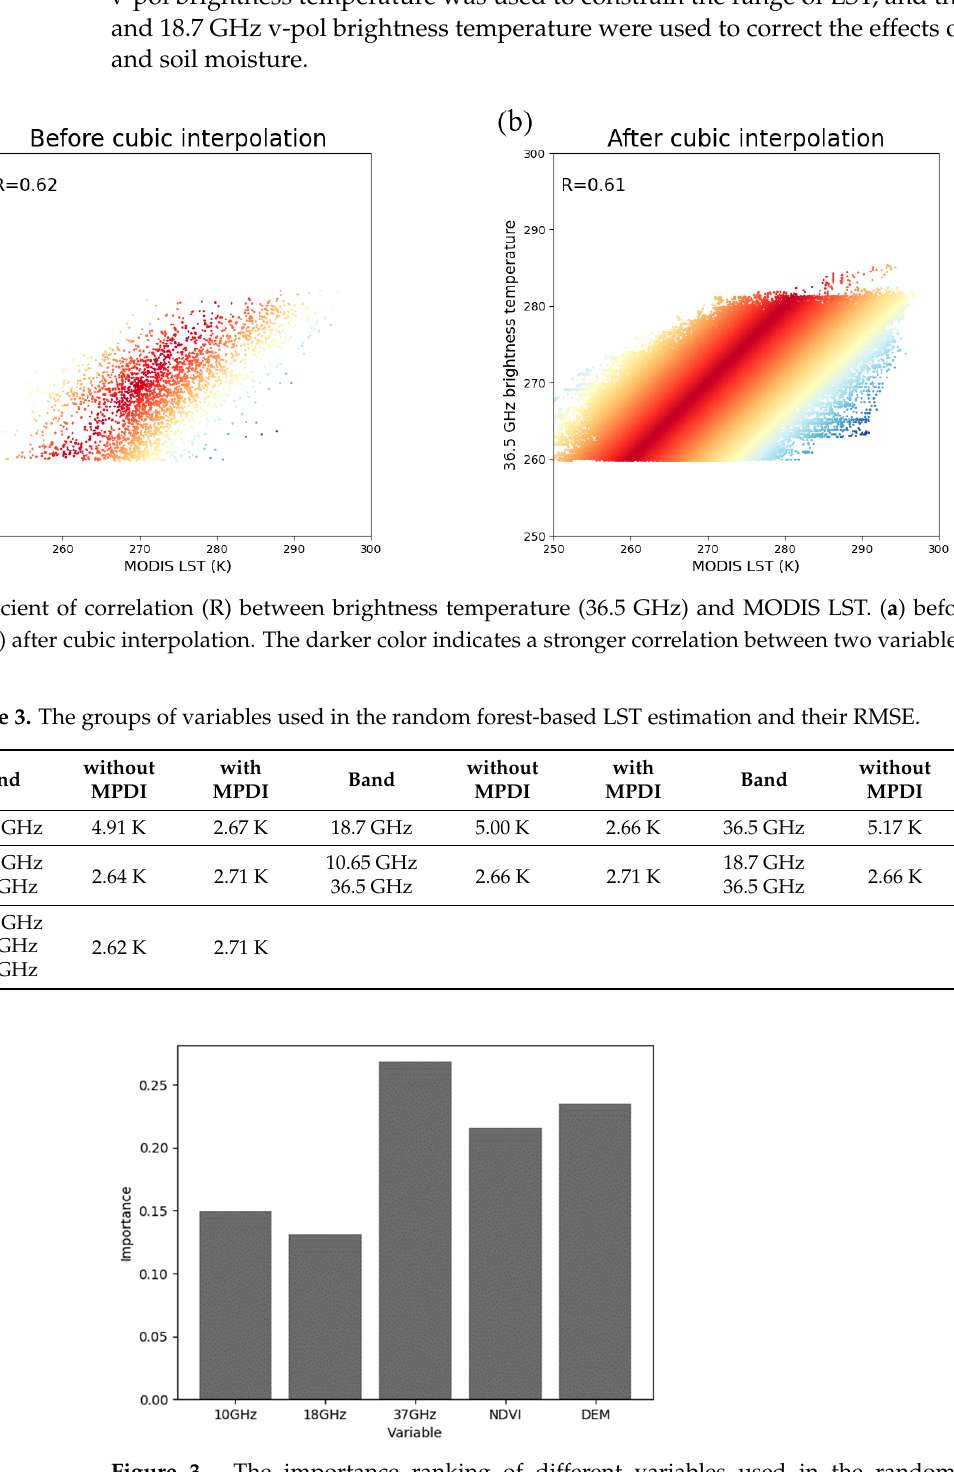
Figure 3. The importance ranking of different variables used in the random forest-based LST estimation.